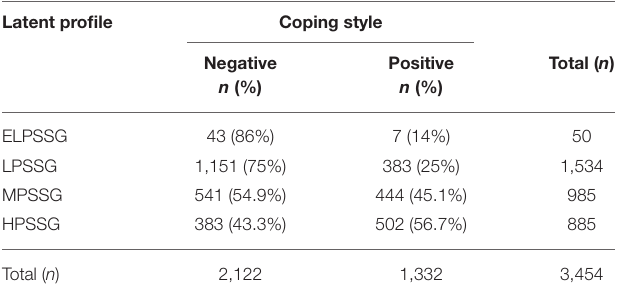
TABLE 2 | Subdivided classes of perceived degree of social support-coping tendency.